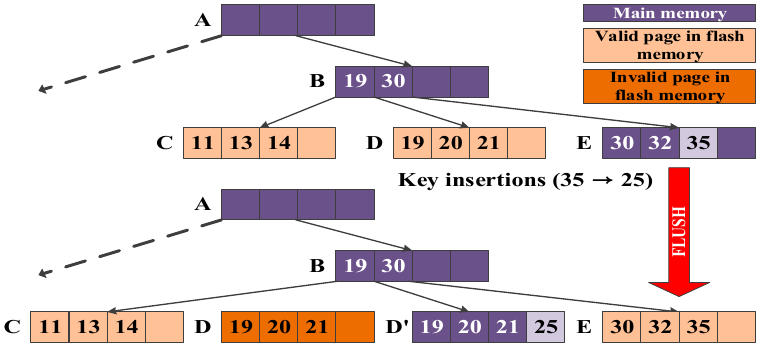
Figure 6. Example of the insert operation.